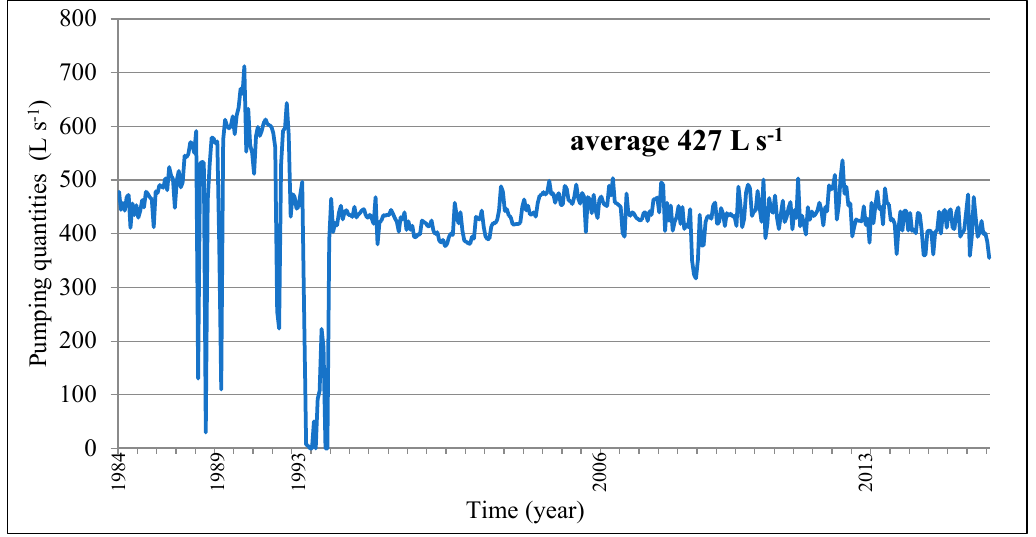
Figure 3. Total pumping quantities of water from 1984 to 2015.